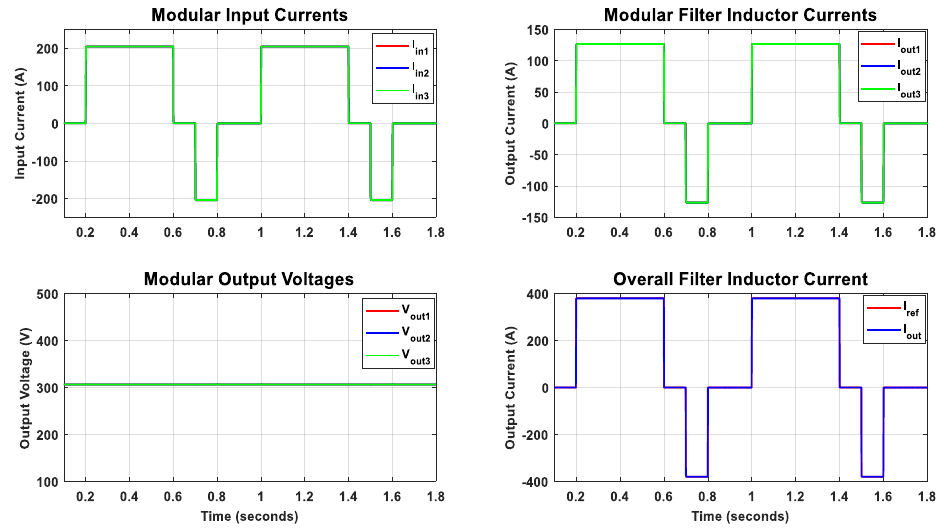
Figure 12. Simulation results for IPOS DC-DC converter.